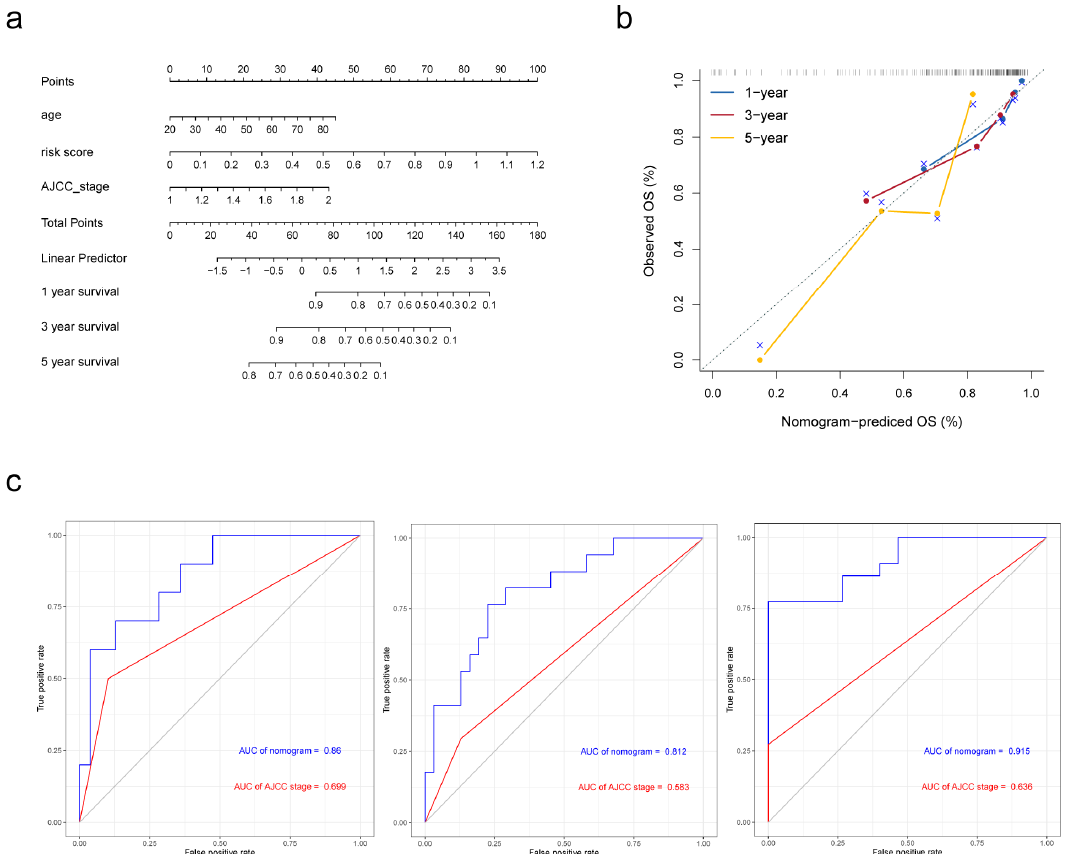
Figure 6. Establishment and validation of the nomogram in predicting overall survival of cirrhotic HCC in the TCGA-LIHC. ( a ) A prognostic nomogram predicting 1-, 3-, and 5-year overall survival rates of HCC. ( b ) Calibration plot of the nomogram for predicting the probability of survival at 1, 3, and 5 years. ( c ) Time-dependent ROC curve of the nomogram for 1-, 3-, and 5-year overall survival predictions comparing with AJCC stage.